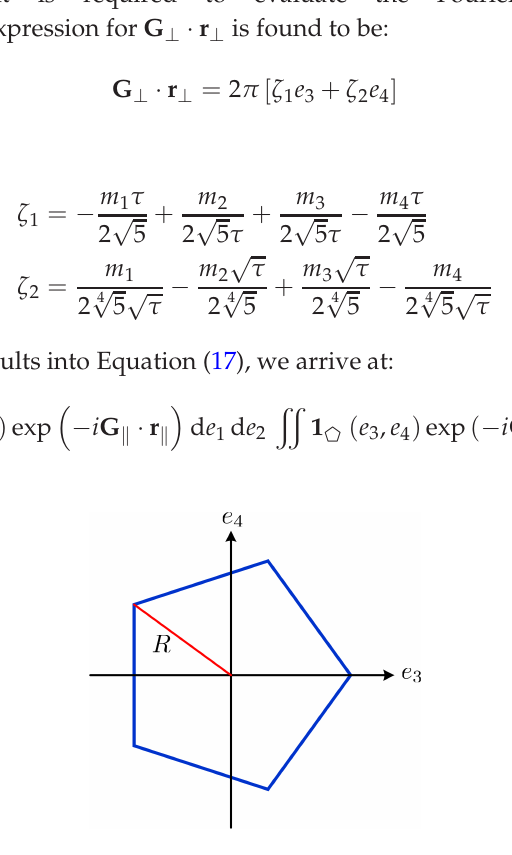
Figure A1. AS is a pentagon of radius R in the perpendicular